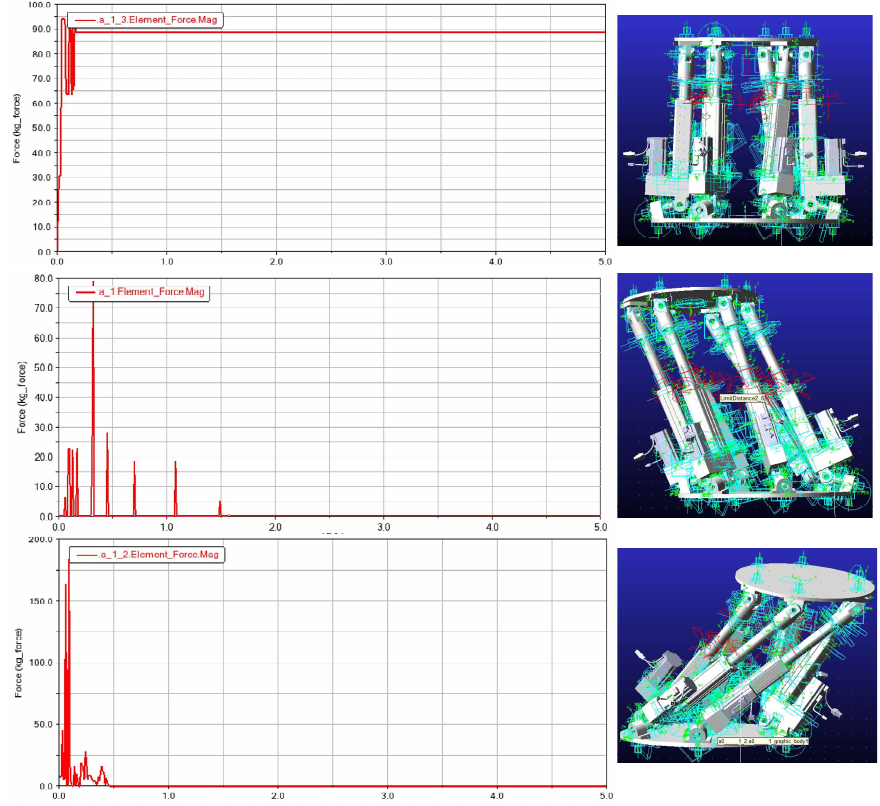
Figure 14. The stress curve of the hinge point by adding 50 kg to the whole machine. According to the stress curve, corresponding to each position of the upper platform, the maximum stress on the hinge point of the lower platform is nearly 200 N, which is less than the maximum load that the motor can